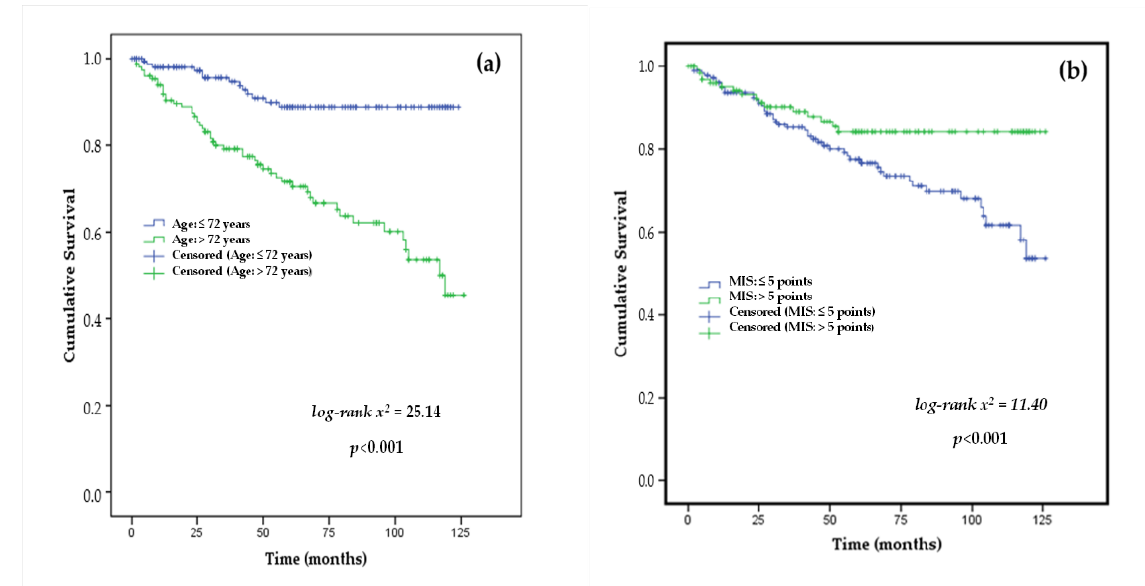
Figure 2. Kaplan – Meier survival curves of the study participants stratified by the cut-off-points of ( a ) age ( ≤ 72 vs. >72 years) and ( b ) malnutrition-inflammation score (MIS: ≤ 5 vs. >5 points) as mortality risk predictors in stage 3b, 4–5 chronic kidney disease patients.